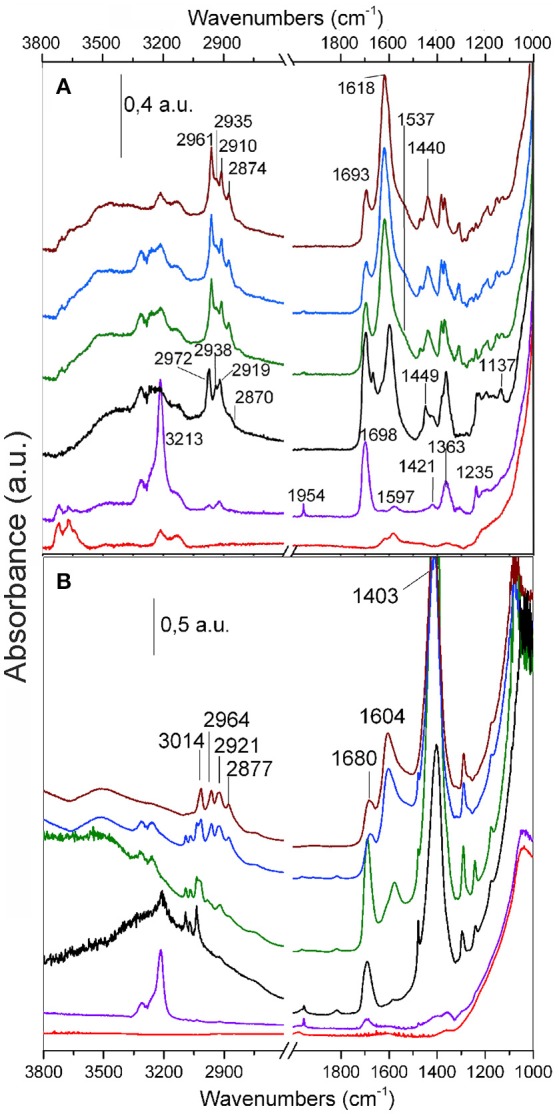
FTIR spectra of C2H2 (120 Torr) adsorbed on TiO2
(A) and MoS2/TiO2
(B). The effect of the increasing contact time and temperature is shown: background (red curves); 1 and 30 min contact time at RT (purple and black curves, respectively); 30 min contact time at 373 and 423 K (green and blue curves, respectively); outgassing at RT (brown curves).